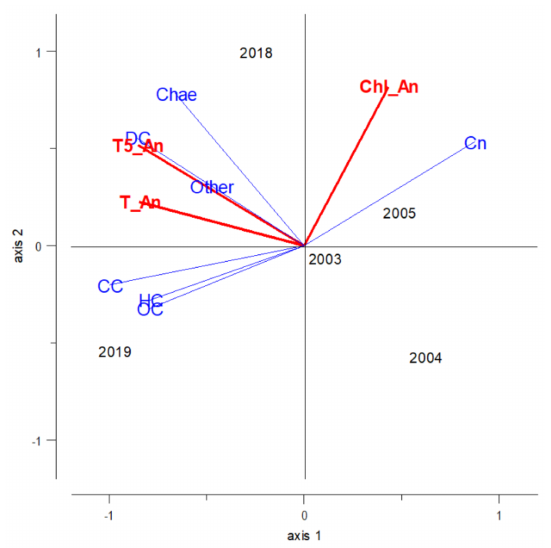
Figure 6. RDA correlation triplot for annual average zooplankton biomass and environmental variables anomalies. In blue: the response variables (zooplankton biomass functional groups); in red: the explanatory variables (monthly anomalies of temperature in the 0–50 m layer T_An, temperature in the 0–5 m layer T5_An, and fluorescence in the 0–50 m layer Chl_An); in black: the five years. (Copepods are divided by trophic strategy: HC-herbivorous copepods, CC-carnivorous copepods, DC-detritivorous copepods, OC omnivorous copepods; Cn-Cnidarians; Chae-Chaetognata; Other- other organisms mainly Cladocera, Appendicularia, Thaliacea and